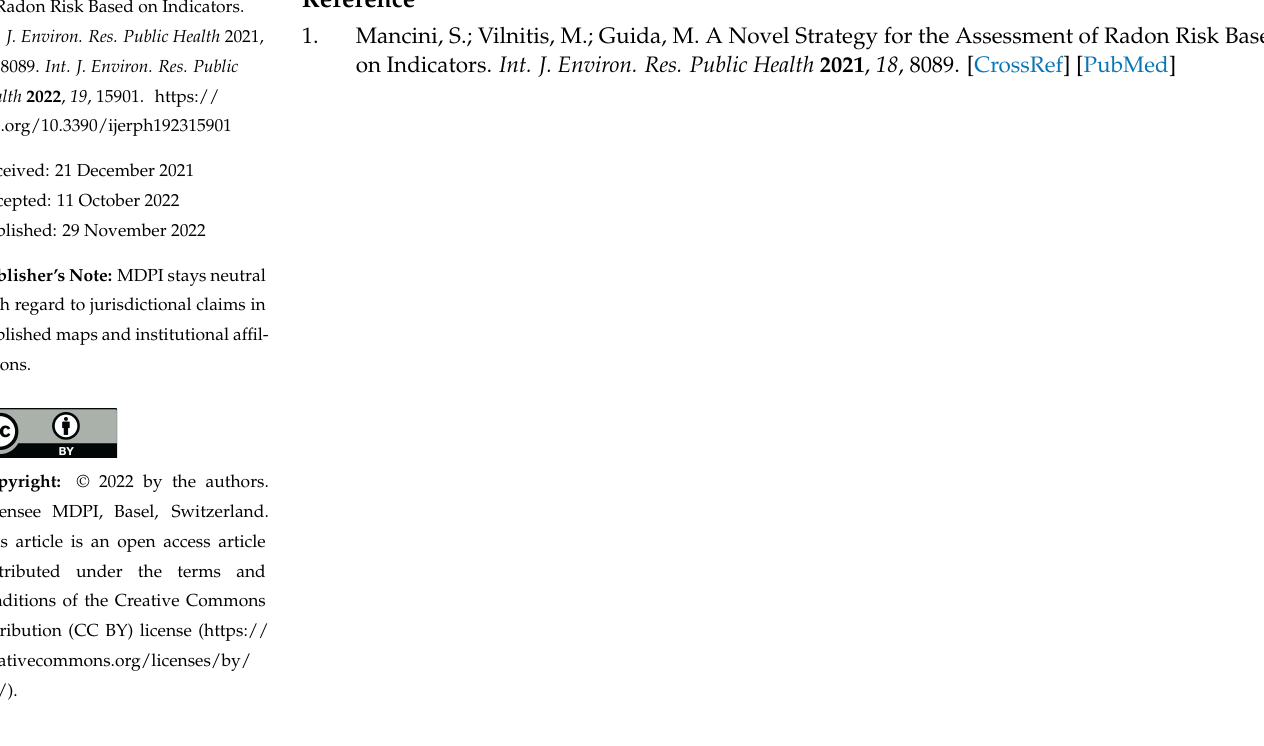
Figure 3. Diagram of the sources (brown square boxes), processes (green round boxes), and parameters that a global dynamic radon model must consider. The time-dependent parameters are in blue. Figure by Font L, available at https://icnts2008.bo.infn.it (accessed on 15 December 2021). Reprinted with permission from Lluis Font